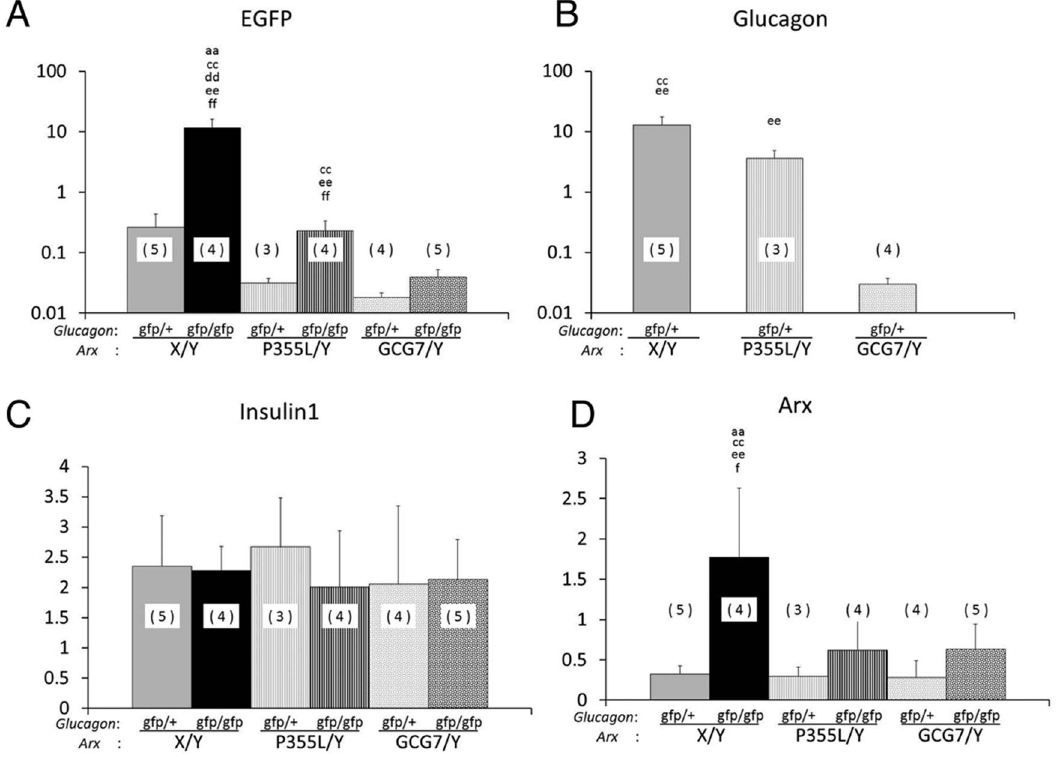
Figure 3. Expression of Gfp , glucagon , insulin and Arx mRNAs in the pancreas of Gcg/Arx double mutant mice. Relative mRNA levels for Gfp (A) glucagon (B), insulin1 (C), and Arx (D) in the pancreas of 2 weeks old mice are shown. Number of animals is indicated in parenthesis in each column. ‘aa’ vs Gcg gfp/ + Arx + /Y , P , 0.01; ‘bb’ vs Gcg gfp/gfp Arx + /Y , P , 0.01; ‘cc’ vs Gcg gfp/ + Arx PL/Y , P , 0.01; ‘dd’ vs Gcg gfp/gfp Arx PL/Y , P , 0.01; ‘ee’ vs Gcg gfp/ + Arx 7/Y , P , 0.01; ‘f’ vs Gcg gfp/gfp Arx 7/Y , P , 0.05; ‘ff’ vs Gcg gfp/gfp Arx 7/Y , P , 0.01.